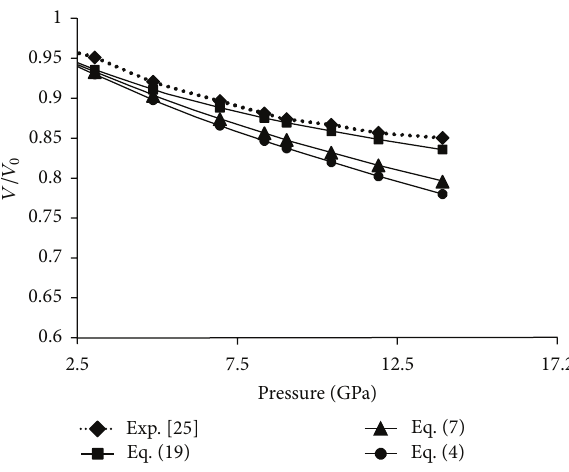
Figure 2: Variation of relative compression ( 𝑉/𝑉 0 ) with pressure for graphite.